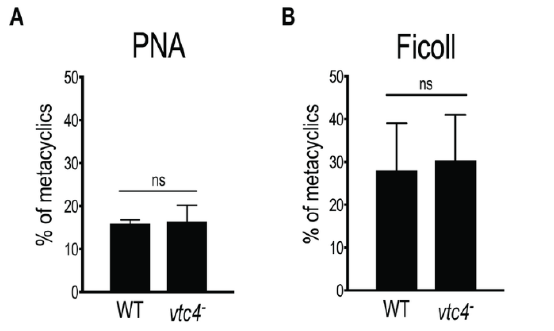
FIGURE 5: Normal metacyclogenesis in absence of polyP in L. major . Metacyclic promastigotes of WT and vtc4 - L. major clones were isolated by PNA assay (A) or by Ficoll centrifugation gradient (B) . Results of a pool of 2 independent experiments were expressed as mean ± SD. Statistical significance was assessed by Student’s t-test (A and B) ; ns: non-significant.